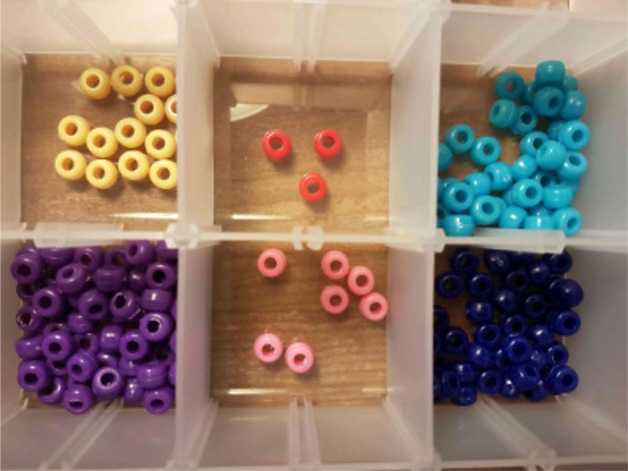
Illustrating the CoHSI homogeneous model. In each bin, all of the tokens are identical (i.e. of the same colour). Each bin contains tokens of a different colour and the beads are by definition in no distinguishable order.